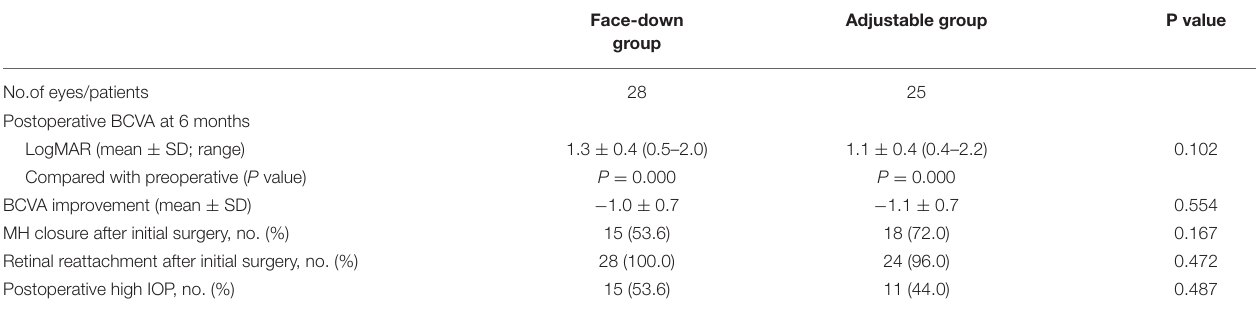
Adjustable group